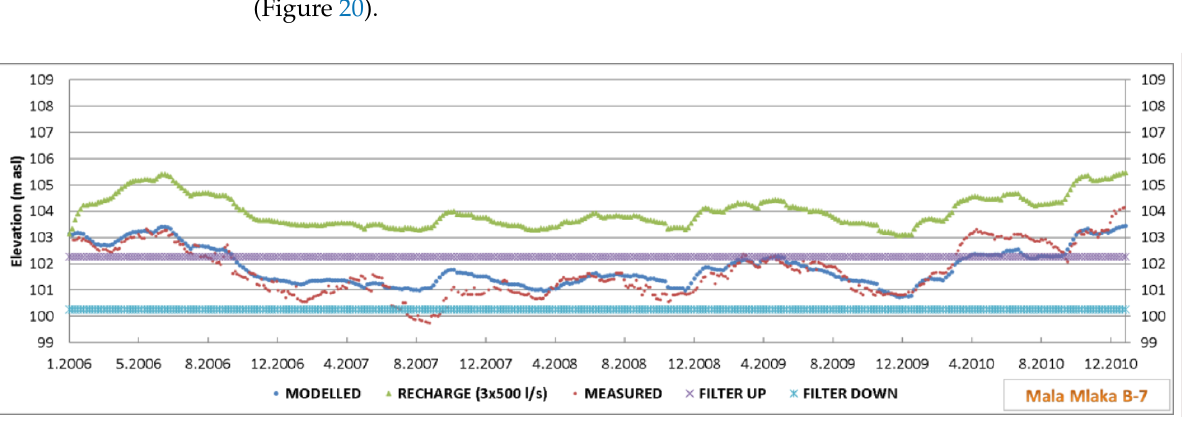
Figure 20. Influence of the MAR with injection wells (3 × 500 L/s) on well